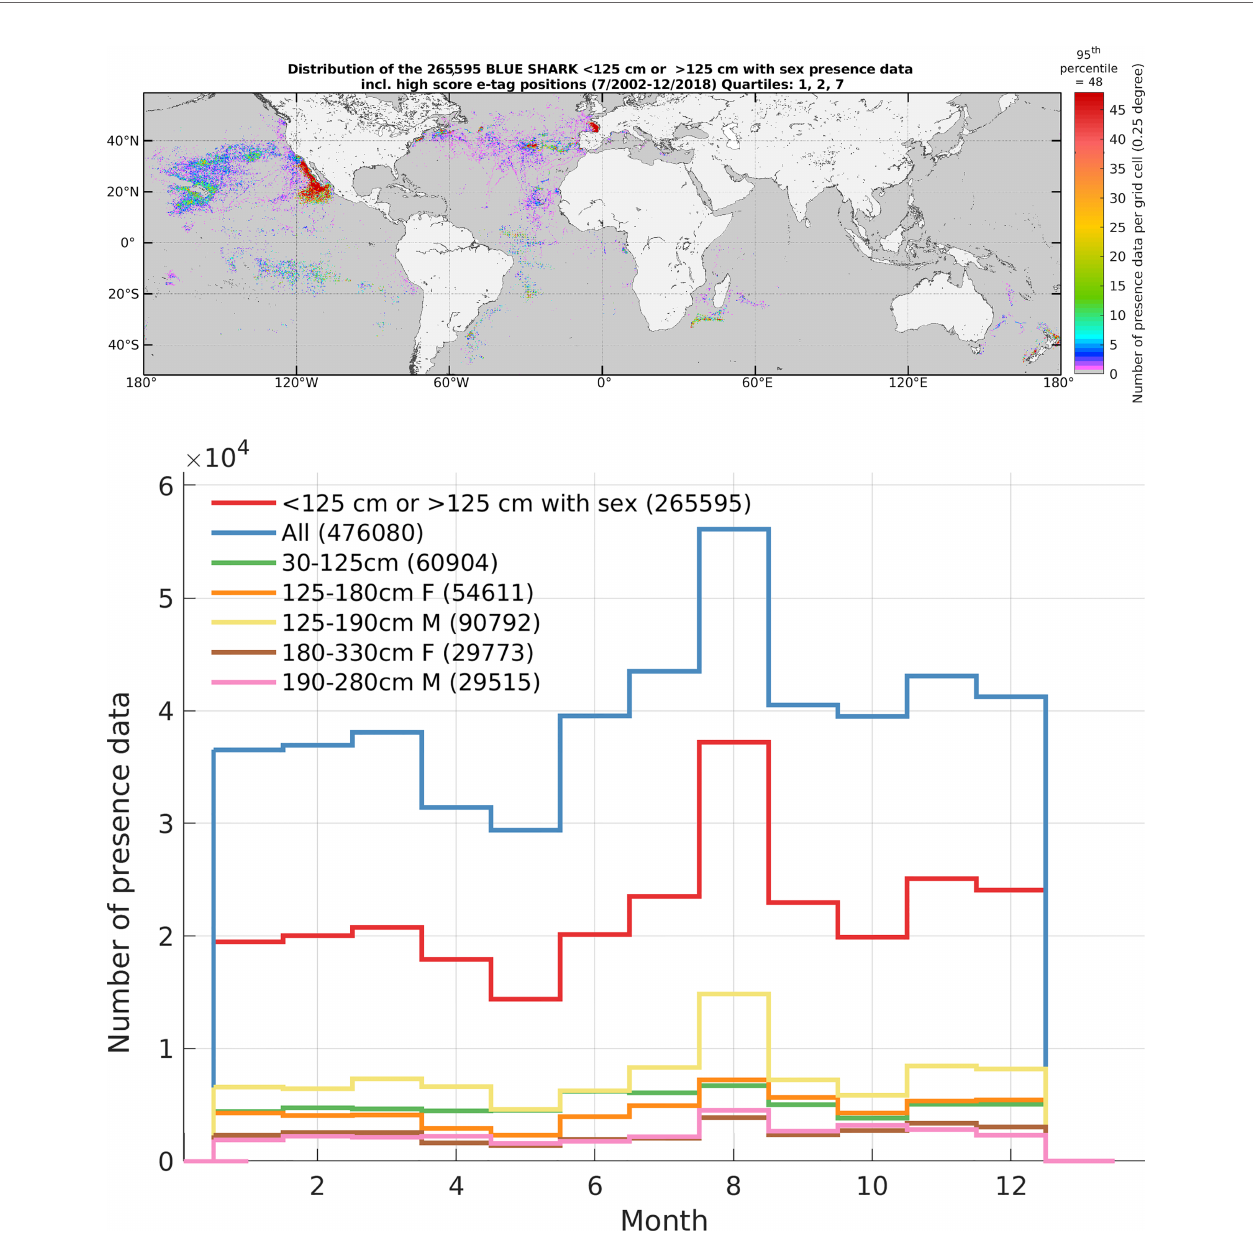
FIGURE 1 | Distribution of both calibration and validation presence data (FL < 125 cm and FL > 125 cm with sex information, upper map, n = 265,595, number of presence data per grid cell of 0.25°), and monthly distribution by size and sex class ( ‘ All ’ corresponds to all presence data contemporary to environmental data independently of size and sex availability). These data are mainly derived from fi sheries observer (94.5%) programs, but include a small amount of data from electronic tags (one position per day of higher accuracy, 5.5%). See in Supplementary Material the Figures SM.1-5 on the distributions by size and sex classes, and seven video animations of habitat in regions of high-density electronic tagging